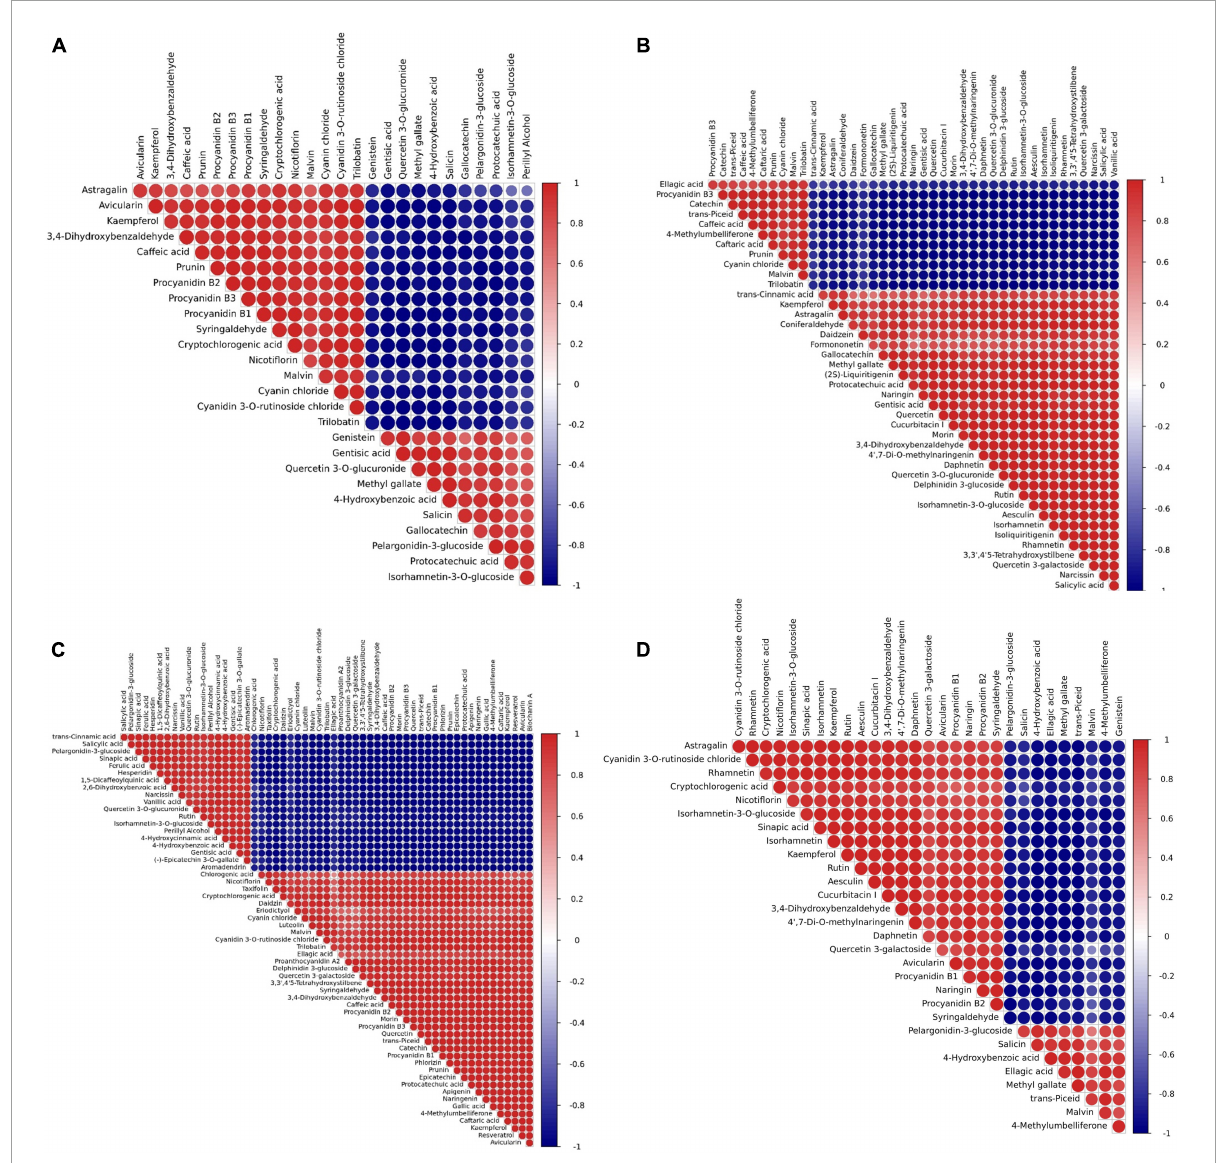
FIGURE5 Pearson correlation analysis results for differential metabolites by pairwise. (A) YH29 and WH10; (B) ZH12 and WH10; (C) WH10 and KNB; and (D) YH29 and ZH12. Dark red represents a significant positive correlation. Dark blue represents a significant negative correlation.